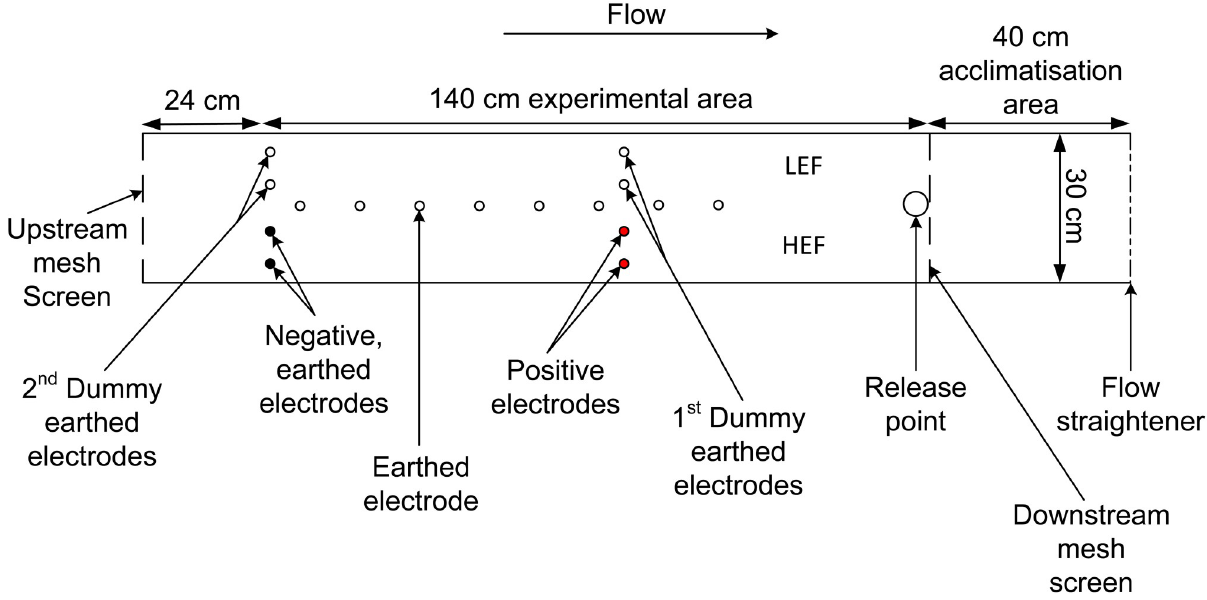
Fig 1. Experimental set-up used to investigate route choice of upstream moving juvenile European eel in response to encountering electric fields of differing strength. The flume was divided by eight centrally placed earthed electrodes separated 12 cm apart. Two positive and two negative earthed electrodes were installed to create a High Electric Field (HEF) strength route along one side of the channel. An adjacent Low EF (LEF) strength route was created by having two sets of two earthed electrodes (1 st and 2 nd dummy earthed electrodes, respectively) at the same longitudinal position as the positive and negative earthed electrodes in the